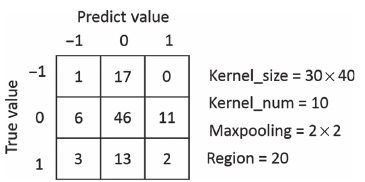
Figure 12: Confusion Matrix of Experiment 2 in Architecture 1.